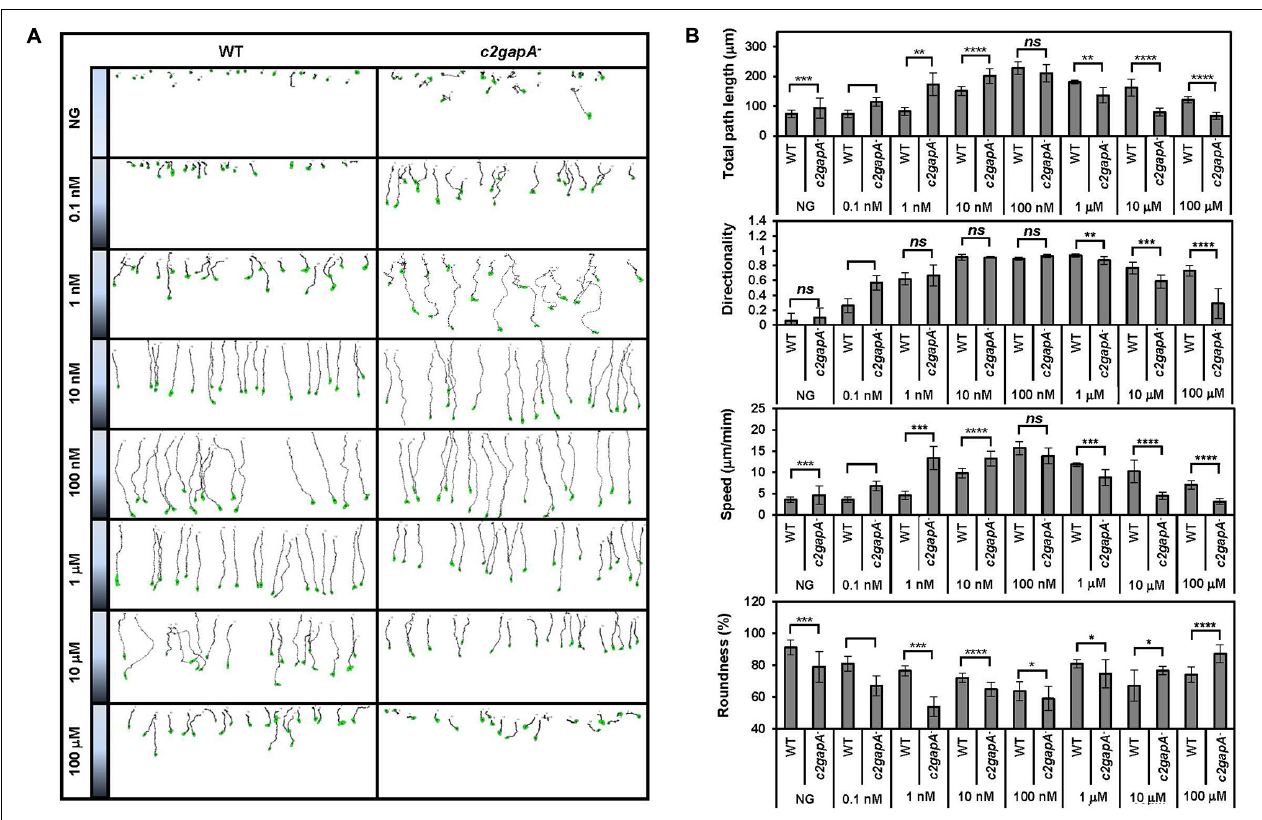
FIGURE 4 | The concentration range of cAMP gradients in which cells chemotax efficiently is upshifted in c2gapA − cells. (A) Montages show the traveling path of chemotaxing WT or c2gapA − cells in response to gradients generated from a cAMP source at wide-range concentrations. Also see Supplementary Video 5 . (B) Chemotaxis behaviors measured from (A) are described by four parameters: directionality, specifically “upward” directionality, where 0 represents random movement and 1 represents straight movement toward the gradient; speed, defined as the distance that the centroid of the cell moves as a function of time; total path length, the total distance the cell has traveled; and roundness (%) for polarization, which is calculated as the ratio of the width to the length of the cell. Thus, a circle (no polarization) is 1 and a line (perfect polarization) is 0. Twenty-five cells in each group were measured for 6.25 min. The mean ± SD is shown. The p -values of Student’s t -test are indicated as ns (not significant, p > 0.1), * ( p < 0.1), ** ( p < 0.01), *** ( p < 0.001), or **** ( p <